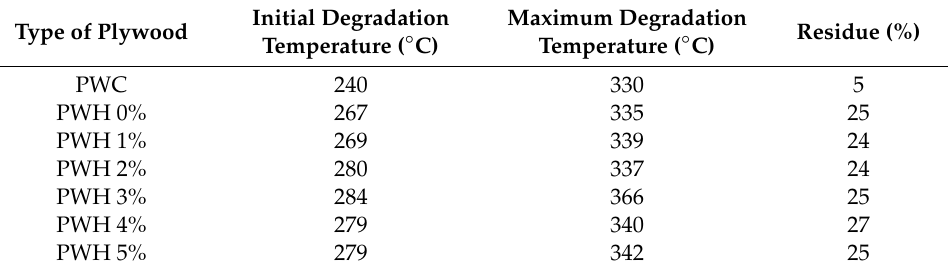
Table 4. Thermal parameters for the thermograms of PWH and